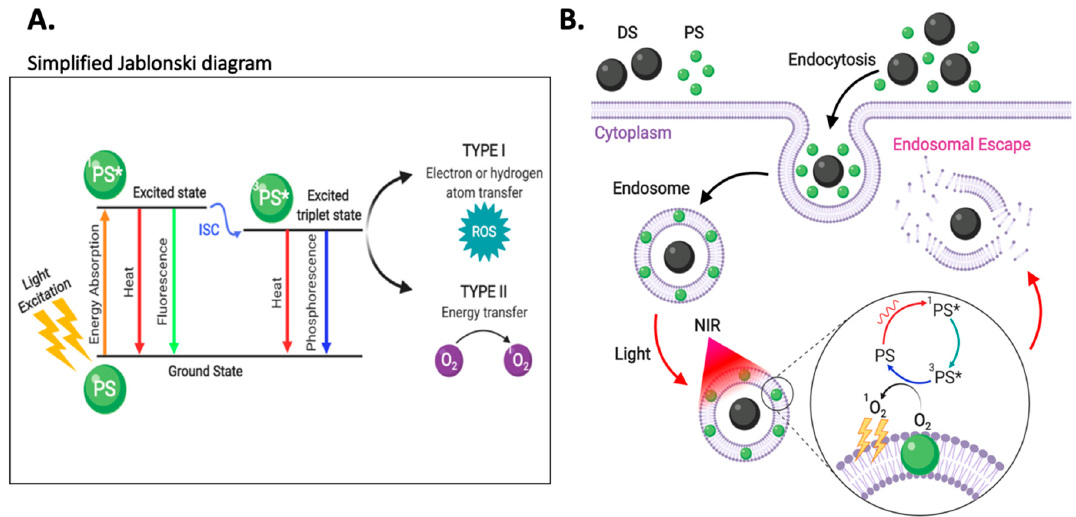
Figure 8. ( A ) Simplified Jablonski diagram showing the different energy transfer events involved in PCI. PS: photosensitizer, ICS: intersystem crossing. ( B ) Schematic illustration of the PCI process. Delivery systems (DS) and photosensitizers (PS) are endocytosed by the cell and colocalized into the endosomal vesicles. PS are mainly localized in the endosomal membranes due to their amphiphilic properties. After NIR irradiation, PS absorb the light energy and transfer it to molecular oxygen, thereby generating highly toxic singlet oxygen. These molecules cause important oxidative damage in the endocytic membranes, which ultimately leads to endosomal escape by their disruption. (Created with BioRender.com).